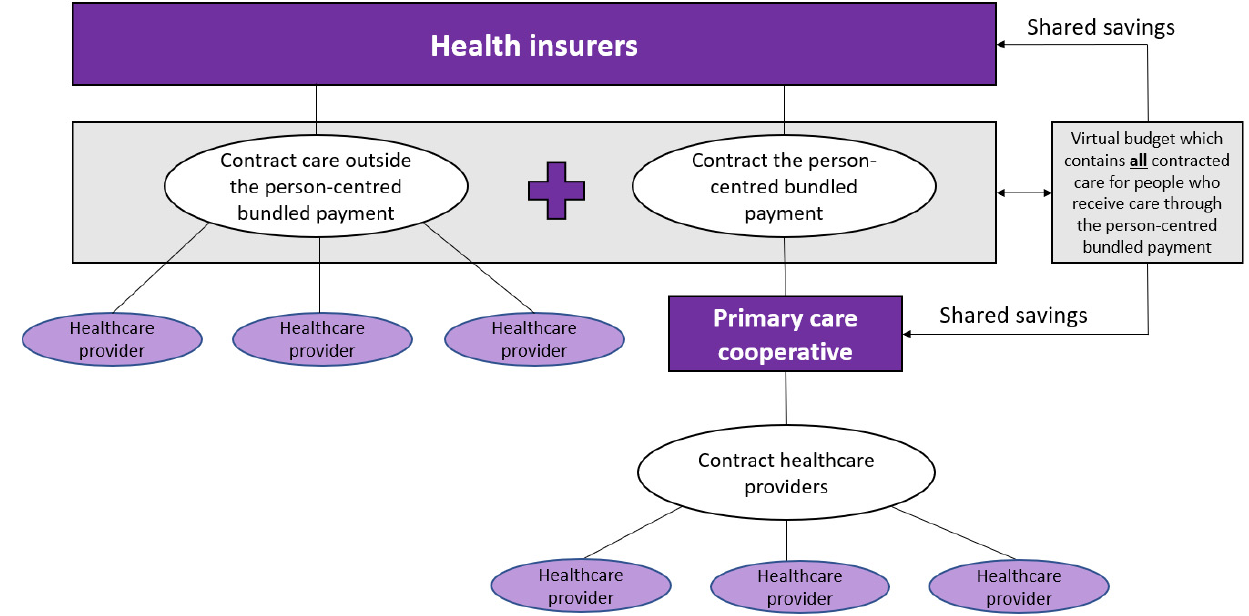
Figure 2. Conceptualization of the person-centred bundled payment in combination with the virtual budget and the shared savings.